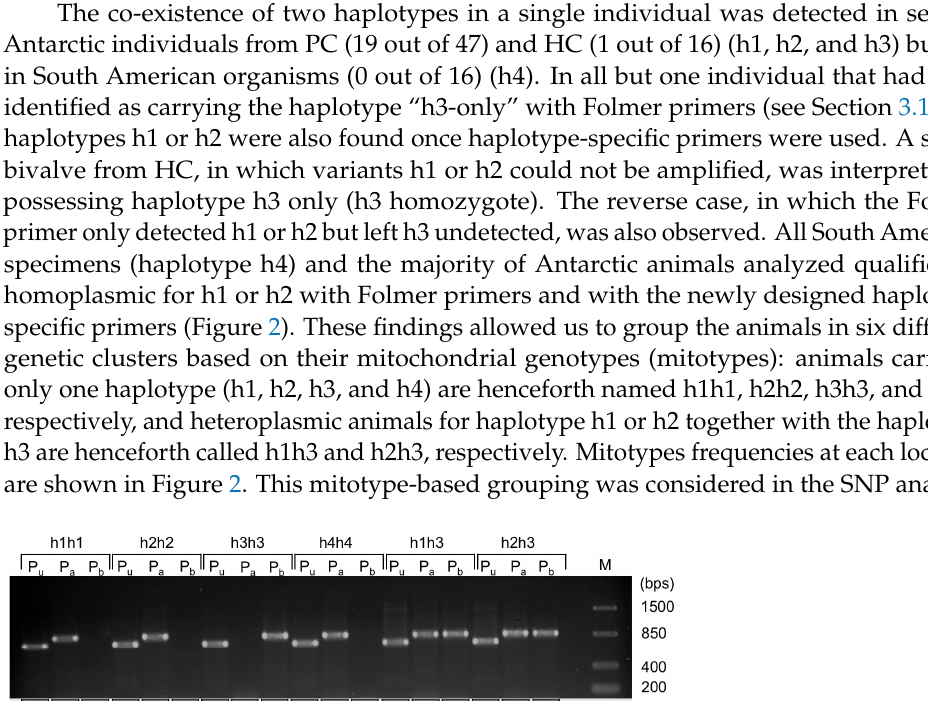
Figure 1. Haplotype network based on COI sequences of Aequiyoldia bivalves ( n = 155) amplified with Folmer primers from Hangar Cove (HC), Potter Cove (PC), and Punta Arenas (PA). Each haplotype is represented by a circle proportional to its frequency (scale top left), and the most frequent haplotypes (>2 individuals) are labeled as h1, h2, h3, and h4.